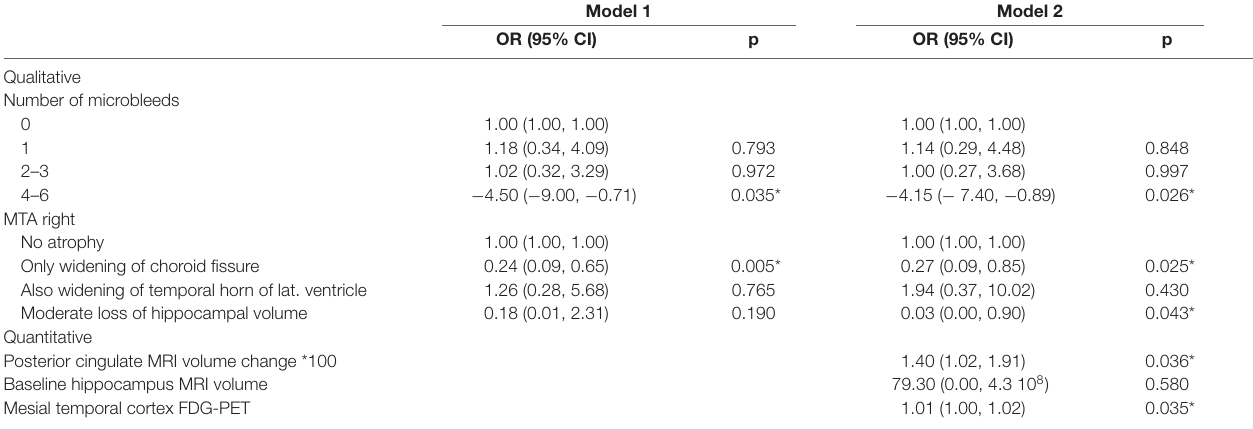
TABLE 4 | Binary evolution of the continuous cognitive score (improvement and null) explained by multiple logistic regressions with qualitative (Model 1) vs. qualitative plus quantitative (Model 2) imaging variables.